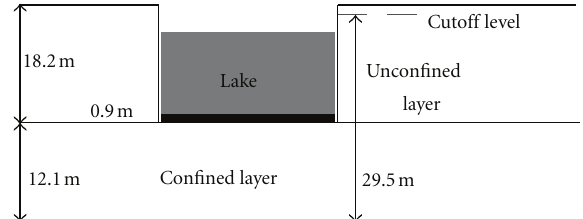
Figure 3: Distorted cross section of study area at reservoir